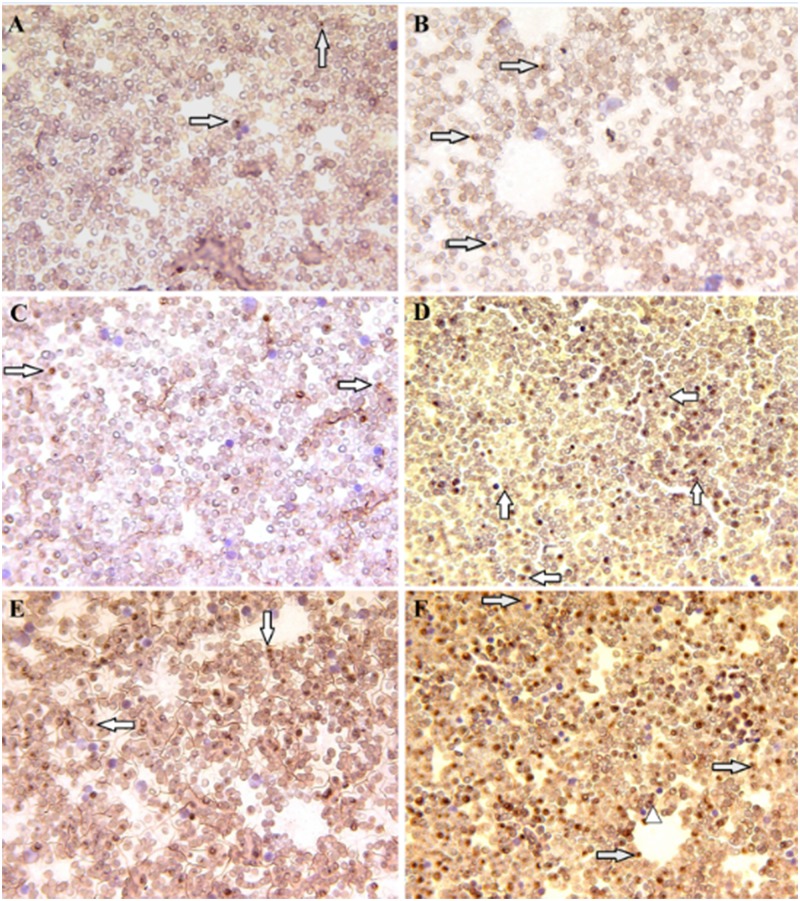
Immunocytochemical (ICC) staining of bone marrow with different infection grades (grades I, II, III and severe infection as grade IV) in dogs of different groups.Panels A and B show infection with grade I and II belonging to G1; panels C and D infection with grades II and III belonging to G2; panels E and F, infection with grades III and IV belonging to G3. Intracytoplasmic leishman bodies (arrow headed), free leishman bodies (arrows), magnification X200.